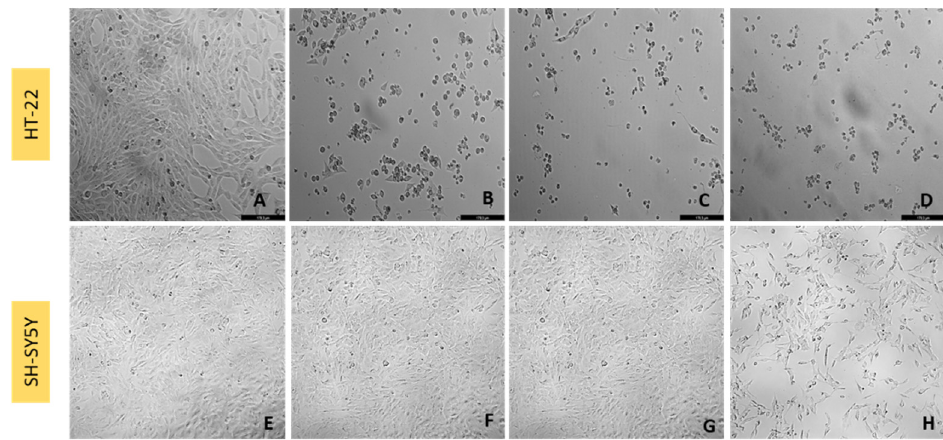
Figure 7. Effect of 48-h-incubation of 100–500 μ M of corticosterone on the viability of HT-22 and SH-SY5Y cells, determined by ( A , C ) MTT and ( B , D ) NR assays. The results represent the mean ± SEM of 3–6 independent experiments, expressed as the percentage of the vehicle (100%). Statistically